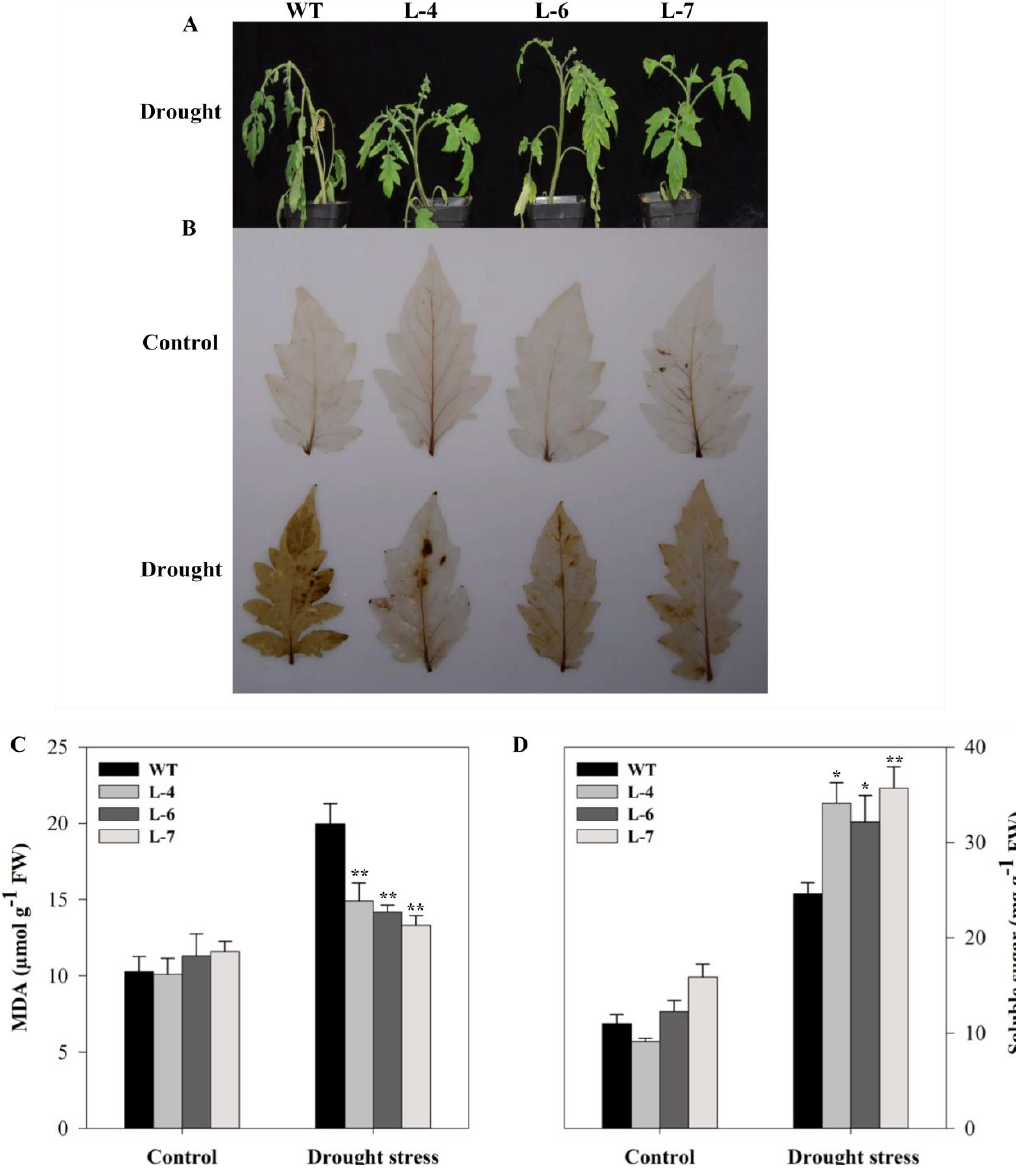
Figure 8. Overexpression of SlMAPK3 alleviated drought-induced oxidative stress in tomato. ( A ) Seedling phenotypes, ( B ) DAB staining for visualization of H 2 O 2 accumulation, ( C ) MDA content, and ( D ) soluble sugar content. Six-week old seedlings of WT and transgenic lines were subjected to drought stress by withholding water supply for 15 successive days and well-watered plants (watered every alternate day) served as a control. For C and D data represent mean ± SE of three biological replicates. **, * significant level differed at p < 0.01 and p < 0.05,